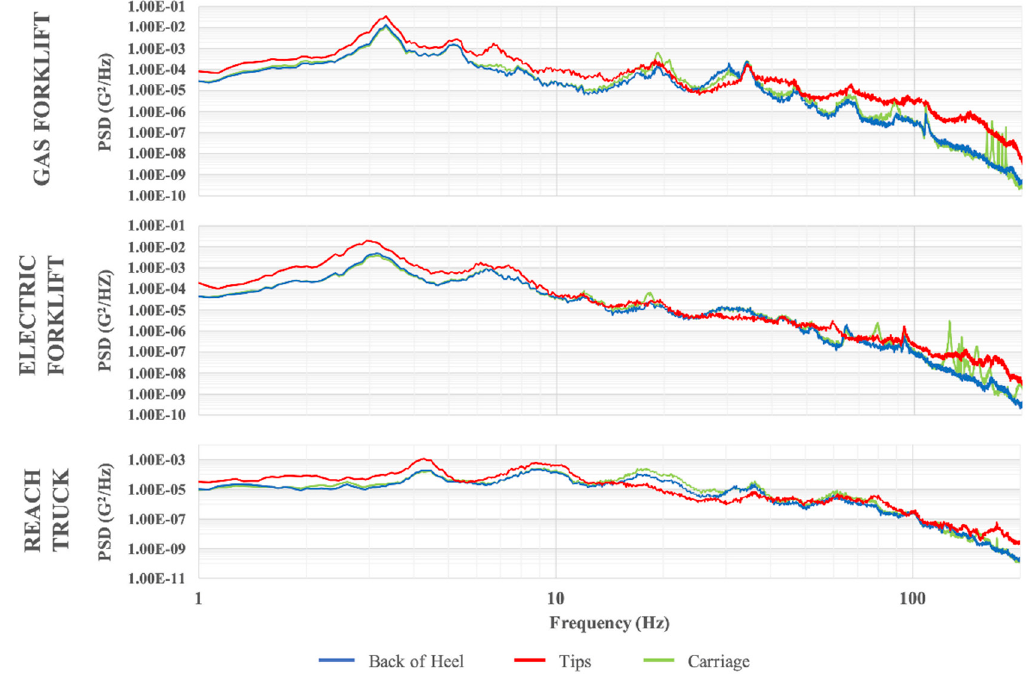
Figure 11. PSD plots of the three investigated forklifts as a function of sensor location (carriage, heel, and tip).